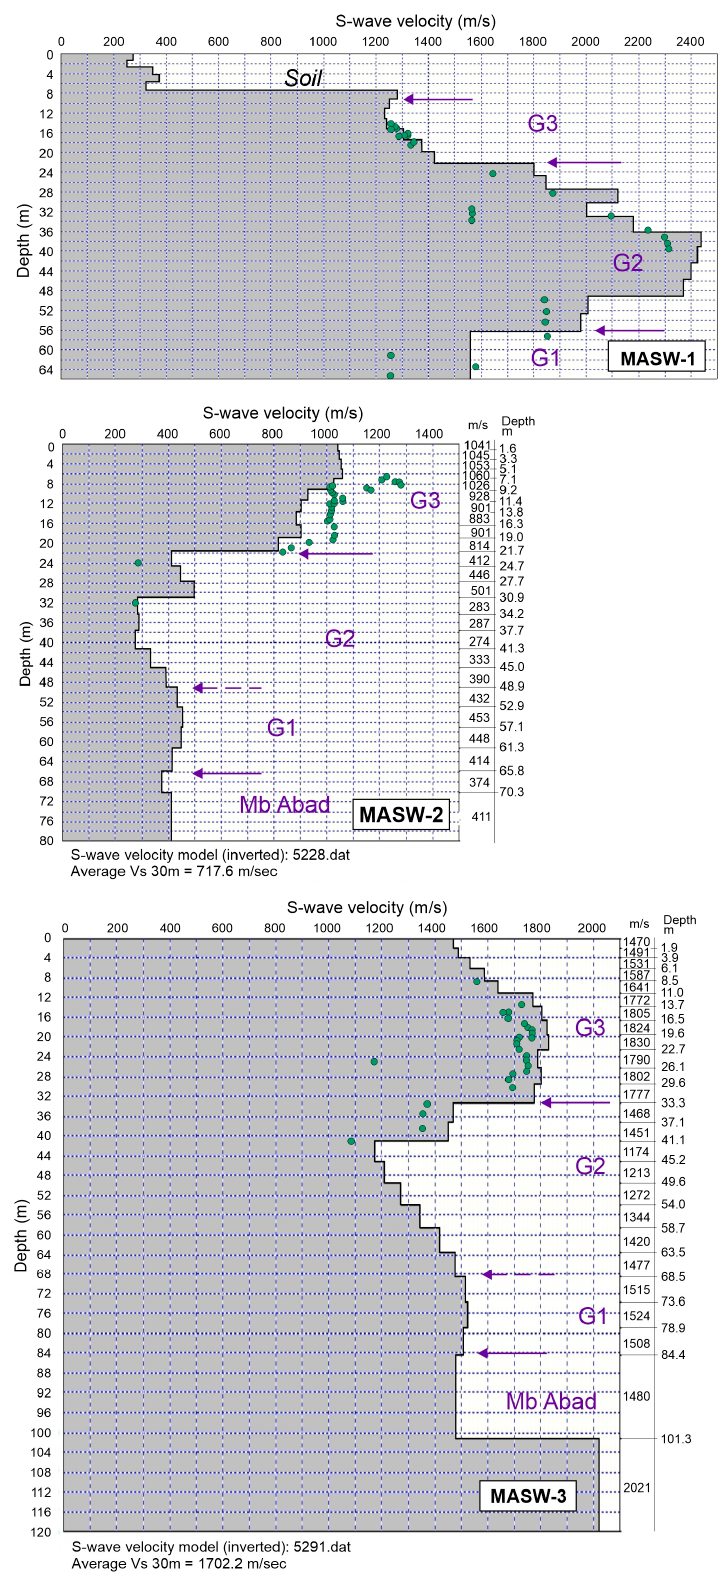
Figure 14. Three 1D seismic surveys (Multichannel Analysis of Surface Waves 1, 2, and 3) conducted on the ERT profile numbers 1, 4, and 5, respectively.